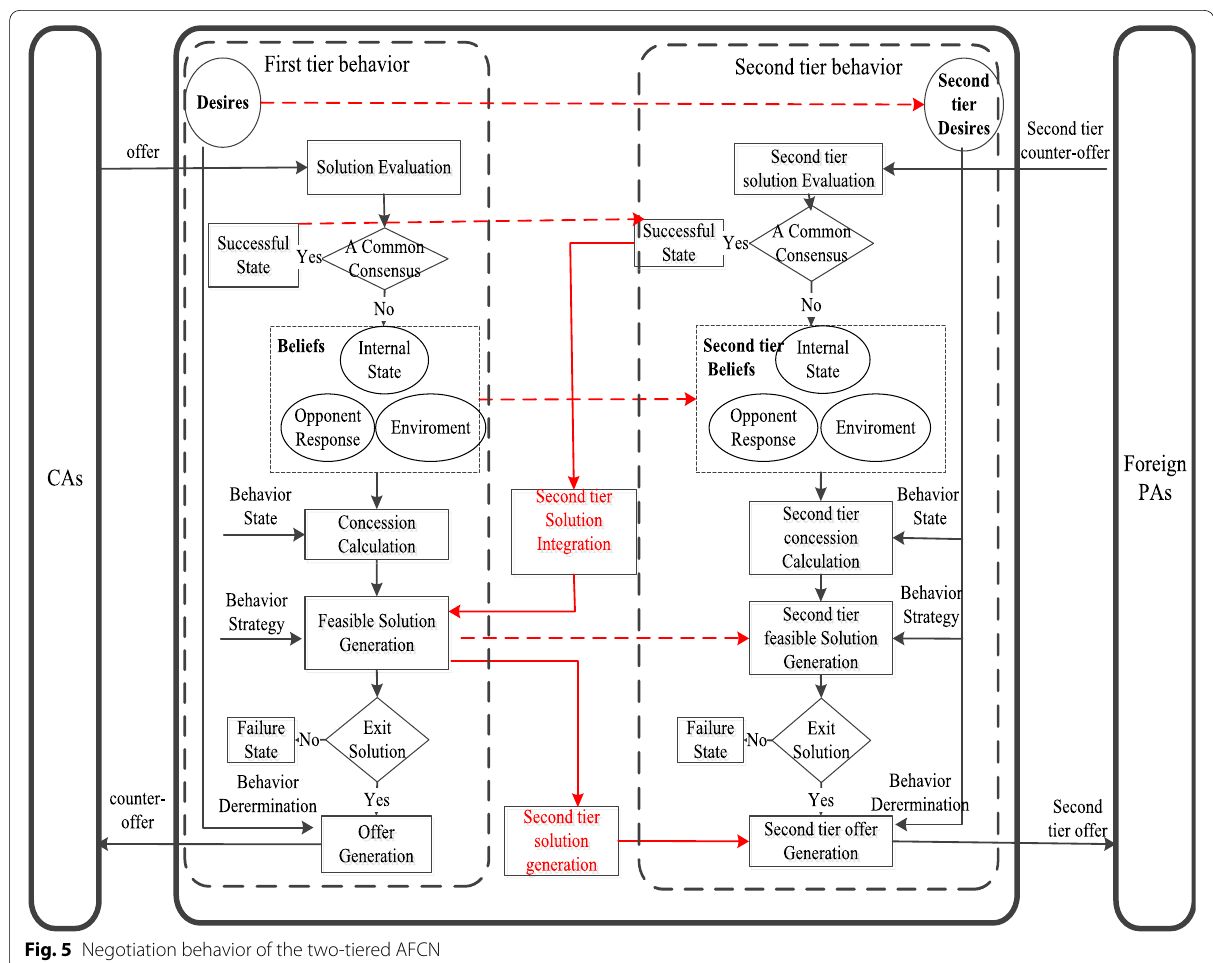
Fig. 5 Negotiation behavior of the two-tiered